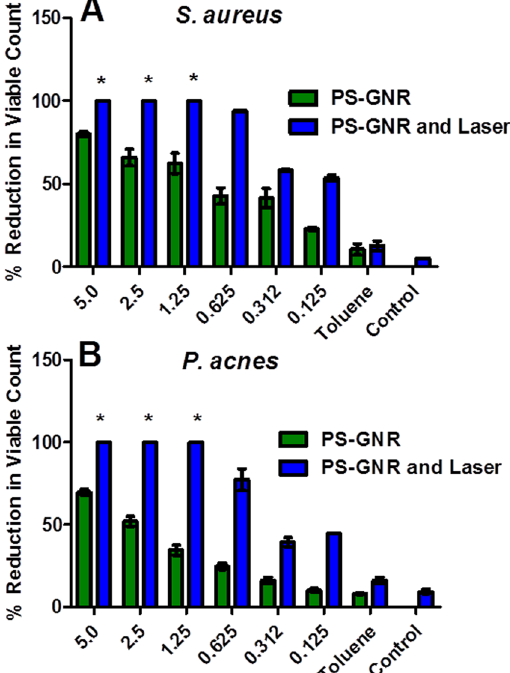
Figure 7. Percentage reduction of bacterial viable count of ( A) S . aureus and ( B) P . acnes pre-treated with PS-GNR alone compared to those treated with PS-GNR followed by laser beam exposure. * Percentage reduction of bacterial viable count ≥ 99.99%, i.e. ≥ 4 log 10 cycles. The standard deviations for the first three bars are very